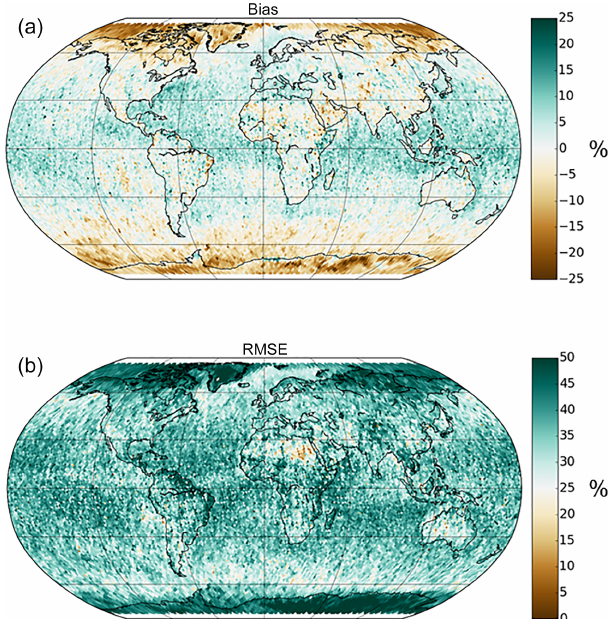
Figure 8. Mean error (bias) and bias-corrected root-mean-square er- ror (RMSE) for the CLARA-A2 cloud amount achieved after filter- ing the CALIOP cloud mask with the cloud optical thickness value of 0.225. Same underlying matchup data set as in Fig. 2. Results are presented in a Fibonacci grid with 75km